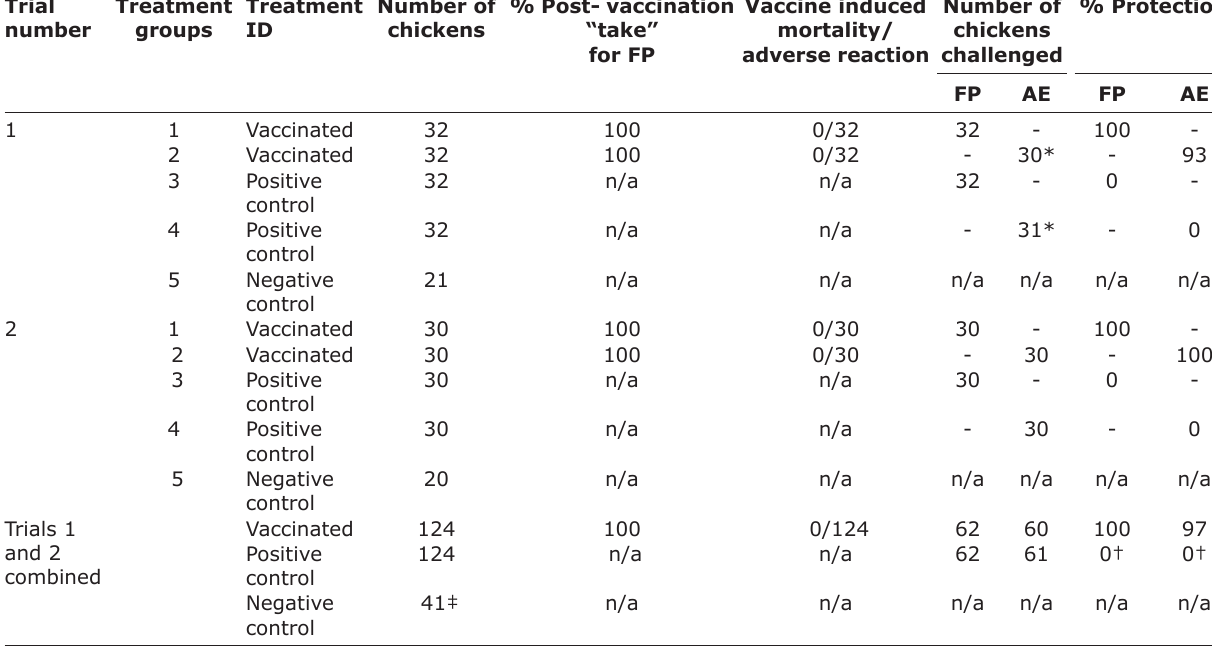
Table-1: Protection in AE+FP+PP vaccinated chickens against challenge with virulent strains of AE and FP. Trial Treatment number groups